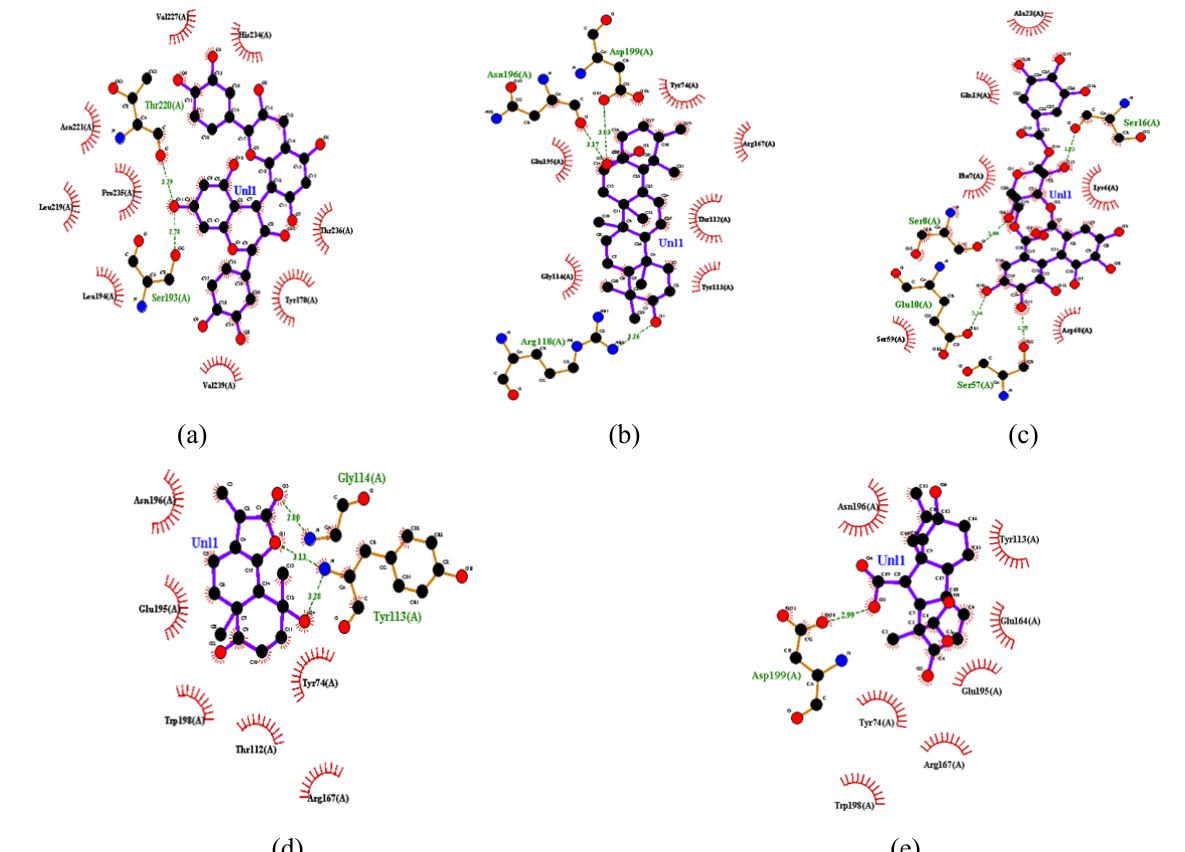
Figure 2. 2D visualization in LigPlot + 2.2 (by EMBL's European Bioinformatics Institute) to show the interaction between abrin and (a) procyanidin B4; (b) ursolic acid; (c) corilagin; (d) vulgarine; and (e) glibberellic acid as virtual screening result using AutoDock